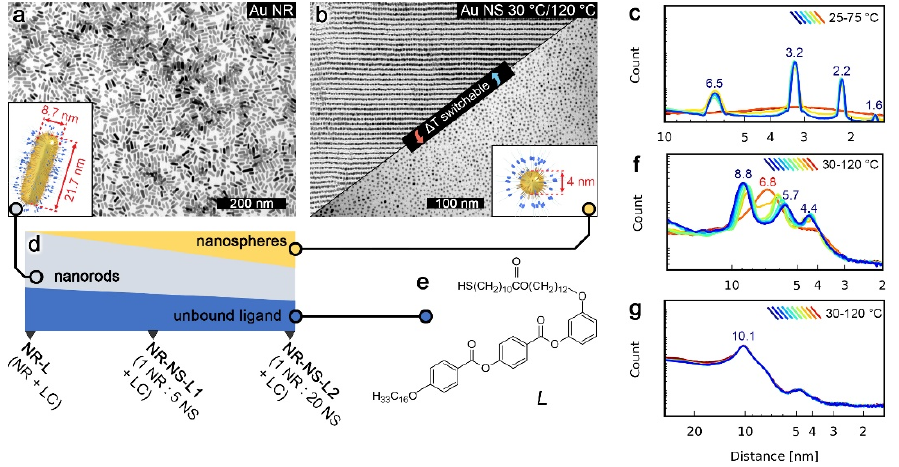
Figure 1. Components and design of the tested NP systems. ( a ) TEM image and a model (inset) of Au nanorods (NRs). ( b ) TEM micrographs and a model (inset) of Au nanospheres (NSs); the upper and lower TEM images were recorded for samples quenched at 30 and 120 ◦ C, respectively, evidencing a thermally dependent structure of NSs in the neat state, in contrast to a static NRs assembly. ( c ) 1D small-angle XRD patterns of the L ligand at different temperatures. ( d ) Graphical scheme indicating composition (by mass-%, unbound ligand bar is magnified 10 × times) of assemblies studied. ( e ) L ligand structure. ( f ) 1D small-angle XRD patterns of Au NSs at different temperatures. ( g ) 1D small-angle XRD patterns of Au NRs at different temperatures; note that the pattern does not change with the temperature.